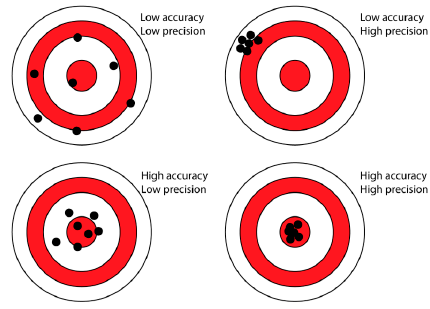
Figure 1. A graphical representation of accuracy and precision. Copyright: www.exammasters.ca.